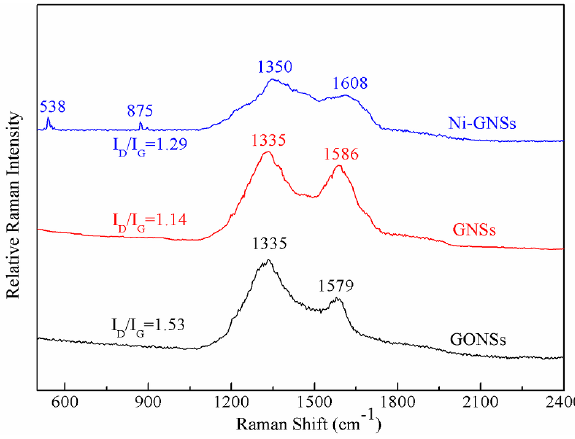
Figure 8. Raman spectra of GONSs, GNSs and Ni-GNSs.